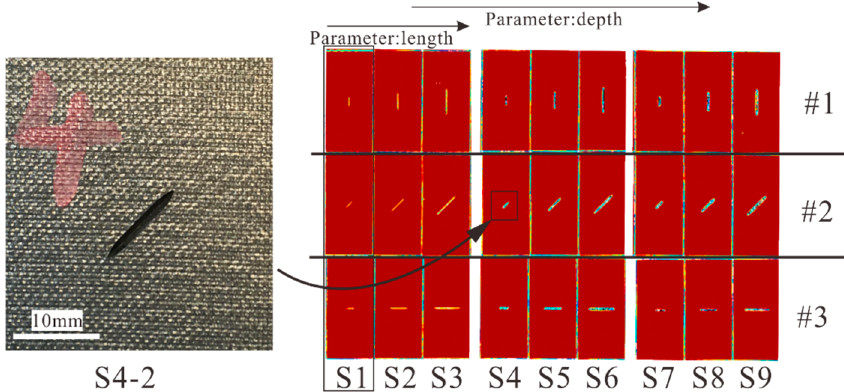
Figure 4. C-scan results of all specimens after crack prefabrication.